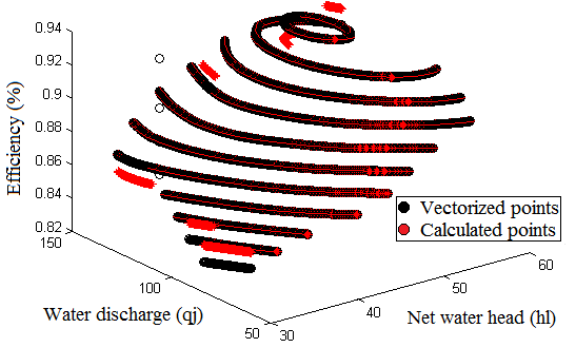
Figure 2. Hill Curve—Overlap: vectorized points of ( q jt ), ( hl jt ) and ( η jt ) and calculated points using ( q jt ), ( hl jt ) data, operative coefficients from regression (by Table 1) and Equation